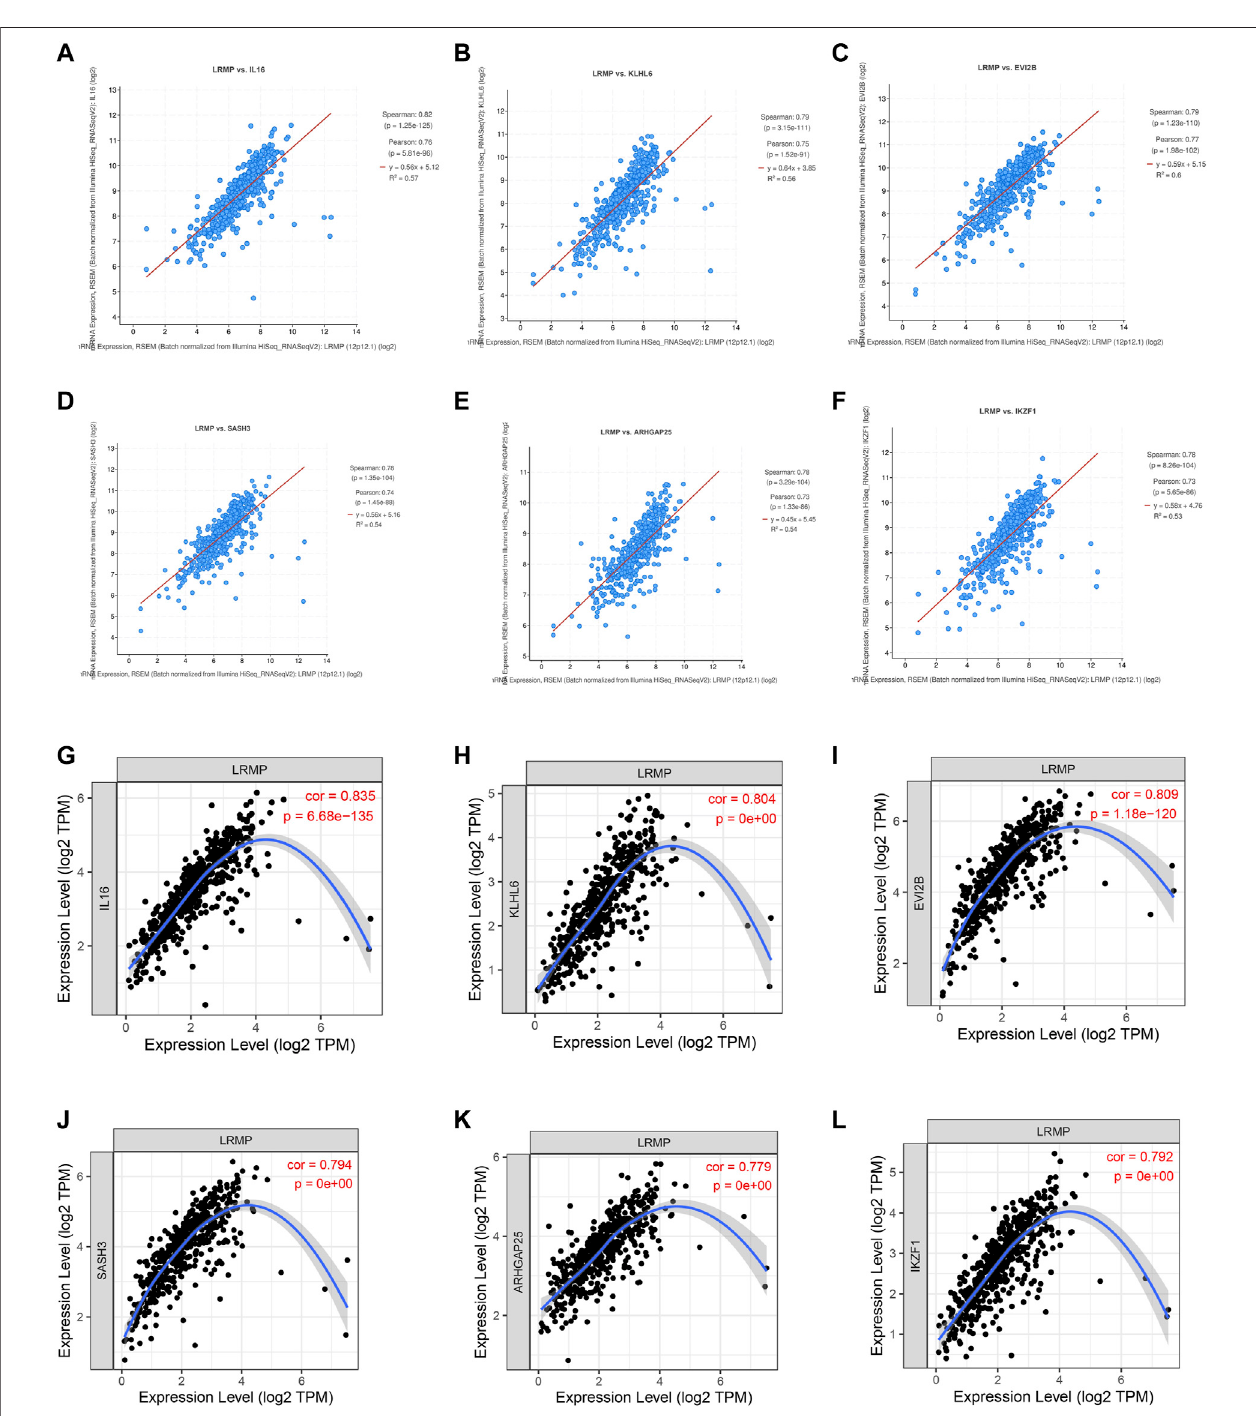
FIGURE6| Co-expressed genes oflymphoid-restricted membrane protein ( LRMP ) inlung adenocarcinoma (LUAD). (A – F) Thegenes co-expressed with LRMP in LUAD were assessed in cBioPortal database. (G – L) LRMP was signi fi cantly associated with IL16 (r (cid:1) 0.835, p (cid:1) 6.68e − 135), KLHL6 (r (cid:1) 0.804, p (cid:1) 0e + 00), EVI2B (r (cid:1) 0.809, p (cid:1) 1.18e − 120), SASH3 (r (cid:1) 0.794, p (cid:1) 0e + 00), ARHGAP25 (r (cid:1) 0.779, p (cid:1) 0e + 00), and IKZF1 (r (cid:1) 0.792, p (cid:1) 0e + 00) in LUAD [ via Tumor Immune Estimation Resource (TIMER) database].